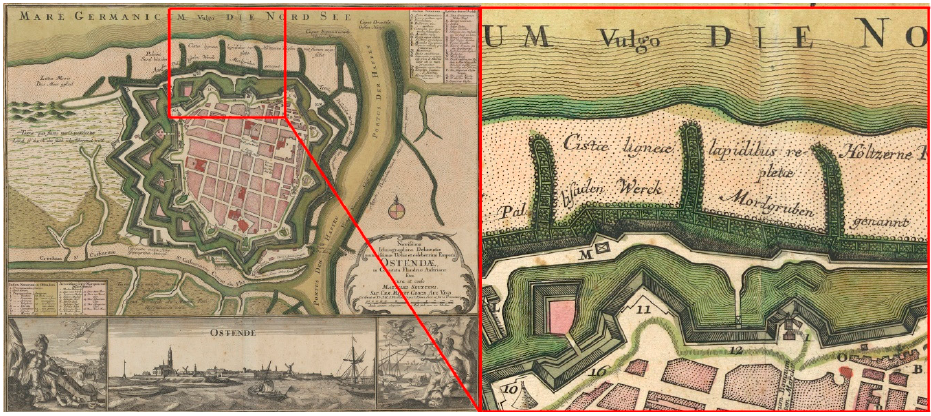
Figure 3. Ostende in a 1734 map by Seutter [20] (detail on the right).